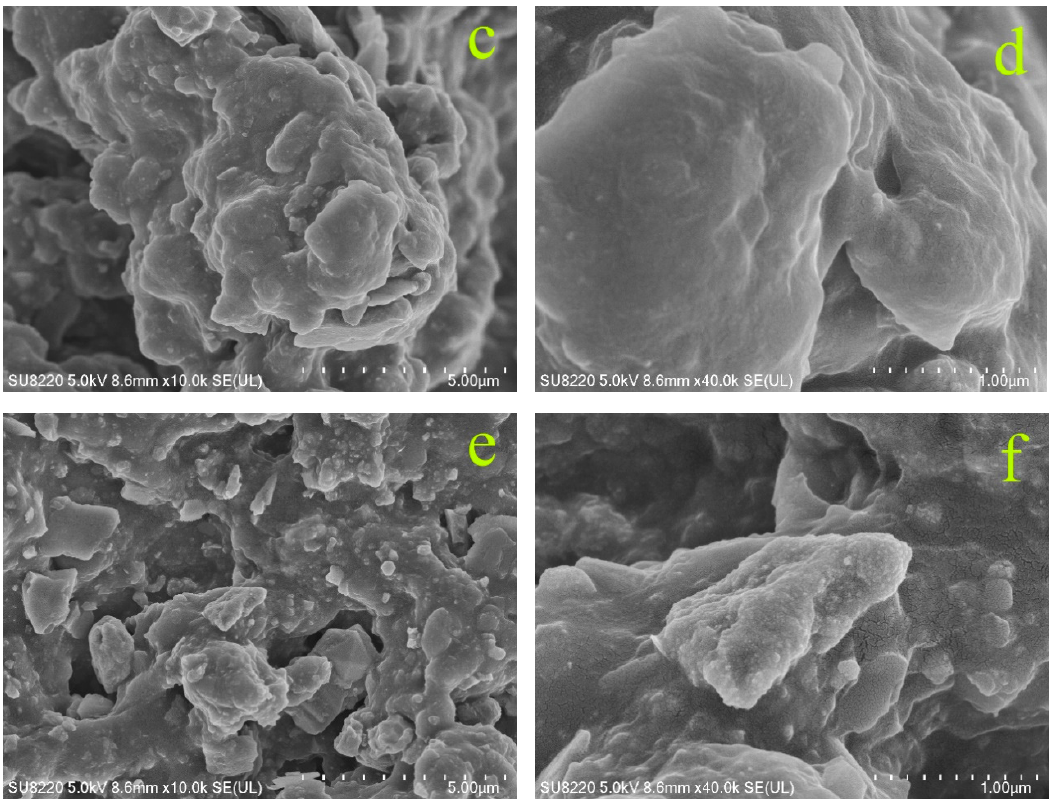
Figure 14. SEM analysis of WRP ( a and b ), 1-ODA-WRP ( c and d ), and 3-ODA-WRP ( e and f ).